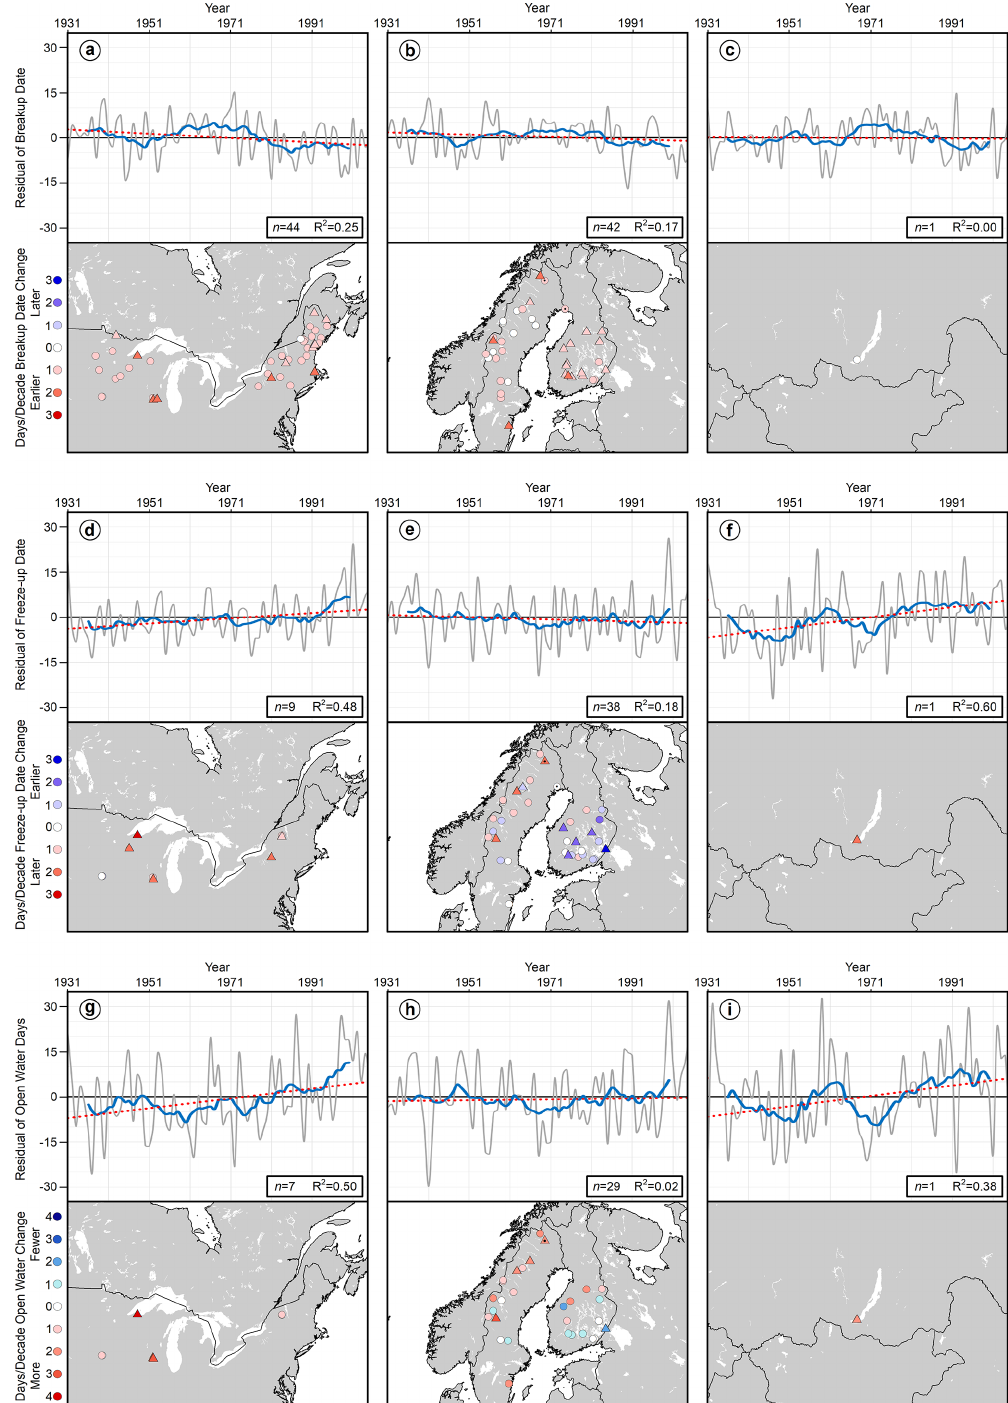
Figure 7. The graphs show the annual residuals (grey) with an 11-year running mean (blue) for ice breakup (a–c) , freeze-up (d–f) , and number of annual open-water days (g–i) across the three regions of study. The dashed red line shows the linear trend for the 11-year running mean and is associated with the labelled R 2 values. The associated maps show the decadal trends for breakup (a–c) , freeze-up (d–f) , and the number of annual open-water days (g–i) . The trend directions and magnitudes were derived from the Mann–Kendall and Sen’s slope tests for the full 1931–2005 time period. The triangles and circles indicate whether the trend was or was not statistically significant. Sites with a dot in the centre of the circle are river sites. Thus, a red triangle symbol with a dot in the middle indicates a river site that has a statistically significant warming trend from 1931–2005. The blue and red tones on the scales are related to cooling and warming trends, respectively. Note that in some places the symbols